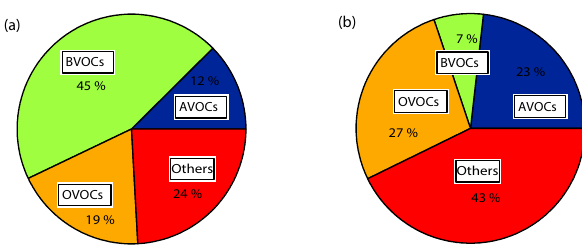
Figure 4. Daytime (a) and nighttime (b) contributions of the mea- sured compounds to the calculated OH reactivity. Daytime data were collected between 07:30 and 19:30LT, while nighttime data were between 19:30 and 07:30LT. Summed OH reactivity during daytime was maximum 11s − 1 , on average 4 ± 2s − 1 , while dur- ing nighttime it was maximum 3s − 1 , on average 2 ± 0.4s − 1 . Bio- genic VOCs (green), AVOCs (blue), OVOCs (orange) and others (red) stand for biogenic, anthropogenic, oxygenated volatile or- ganic compounds, and carbon monoxide and nitrogen oxides, re- spectively. During daytime, BVOCs, AVOCs, OVOCs and others contributions were 45, 12, 19, 24%, respectively, while they were 7, 23, 27, 43%, respectively during nighttime.